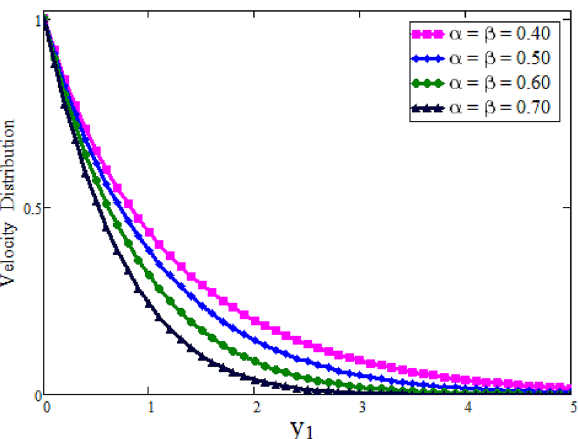
Figure 2. Velocity profile against y 1 due to α for small time, when: t = 0.01 , φ = 0.01 , Pr = 6.2 , Gr = 0.1 and (cid:31) =